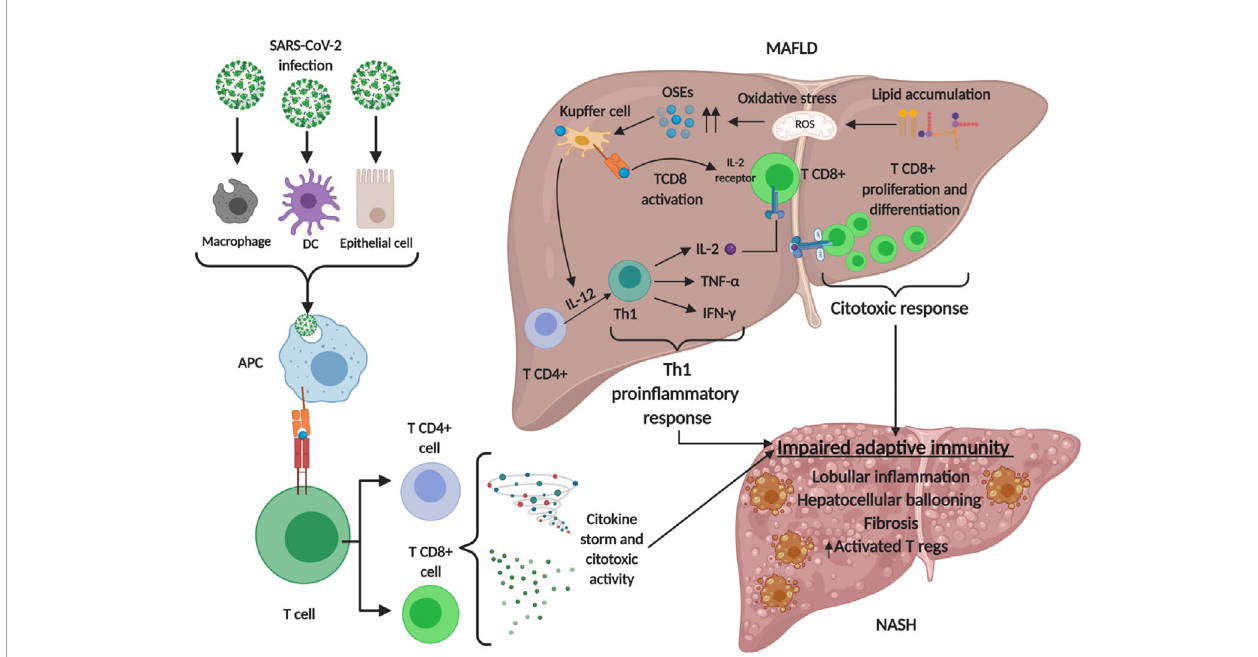
FIGURE 3 | Involvement of adaptive immune system in MAFLD and SARS-CoV-2 infection. Lipid accumulation in metabolic associated fatty liver disease (MAFLD) causes oxidative stress and lipid peroxidation, generating oxidative stress derived epitopes (OSEs). These products lead to adaptive immune stimulating T cells toward Th1 proin fl ammatory phenotype and activating T CD8 cells which express interleukin 2 (IL-2) receptor to develop a cytotoxic response. These events, together with SARS-CoV-2 infection lead to an impaired adaptive immune response. Regulatory T cells (Tregs) in fi ltrate to the liver as a compensatory mechanism for the enhanced local immune response. Created with